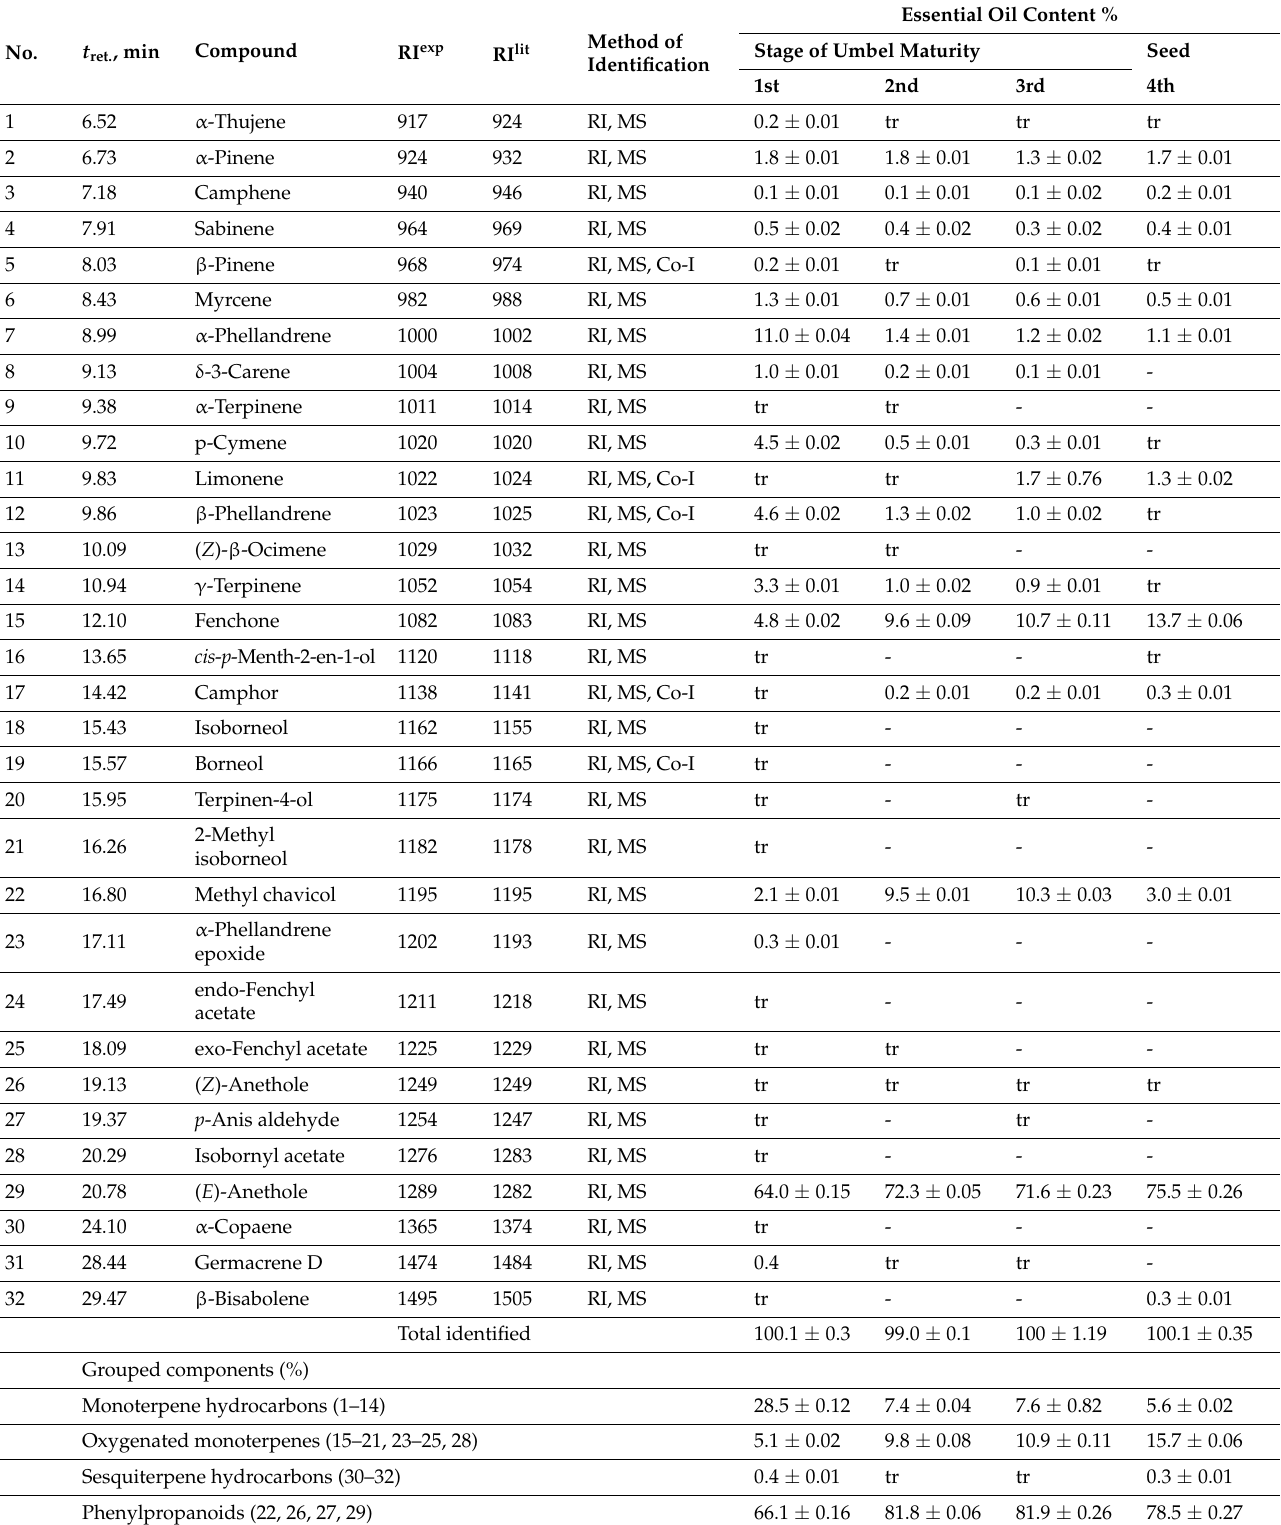
Table 2. Chemical composition of essential oil isolated from wild fennel umbels with